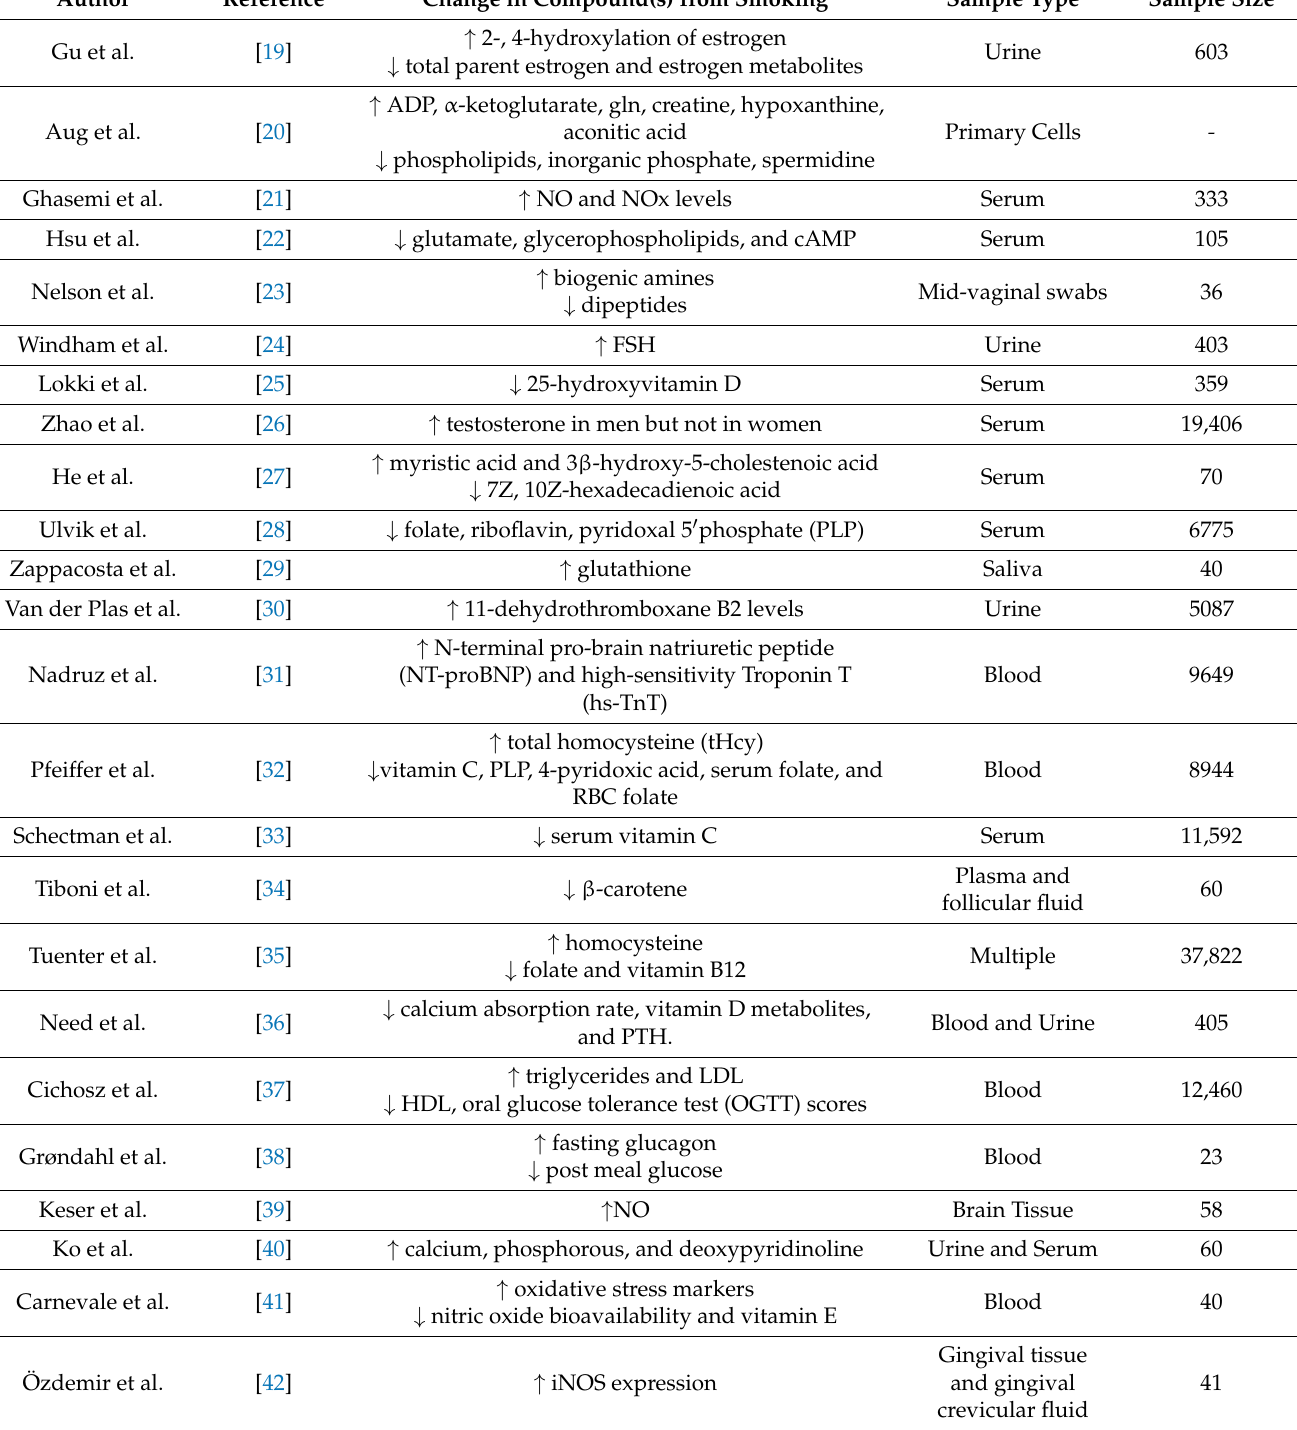
Table 1. Literature review summary for the effects of smoking tobacco on host